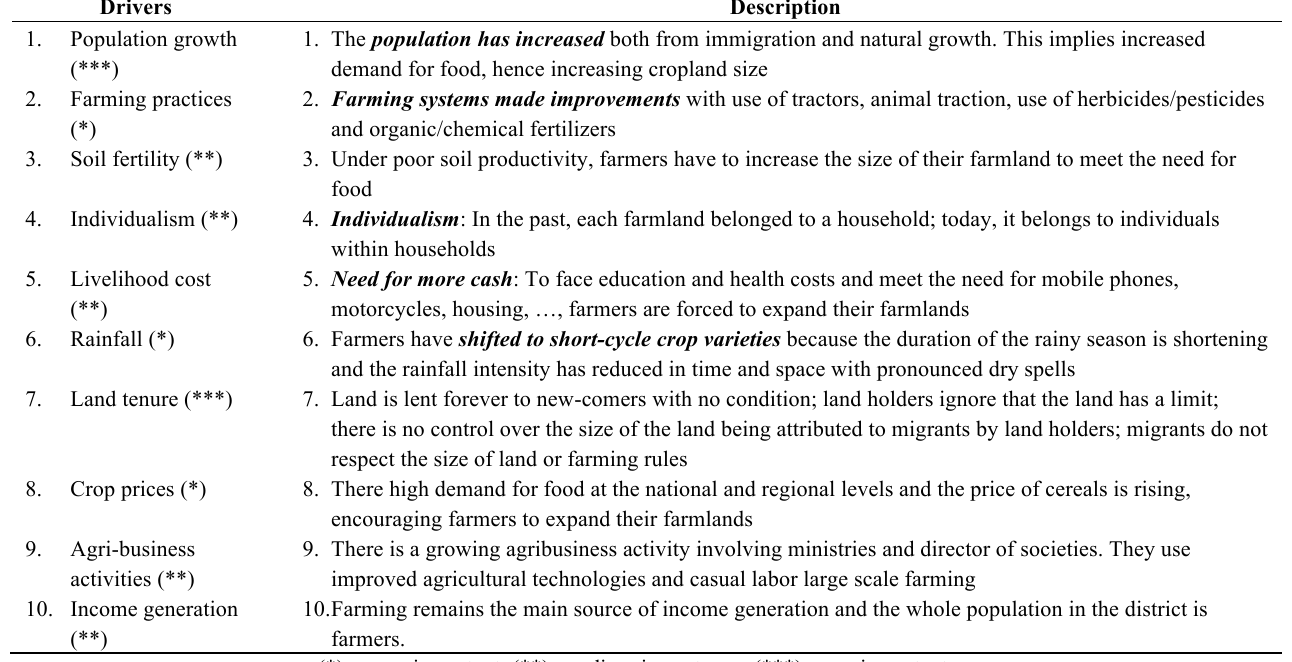
Table 8. Farmers’ perception of drivers of land cover change: change in cropland size.